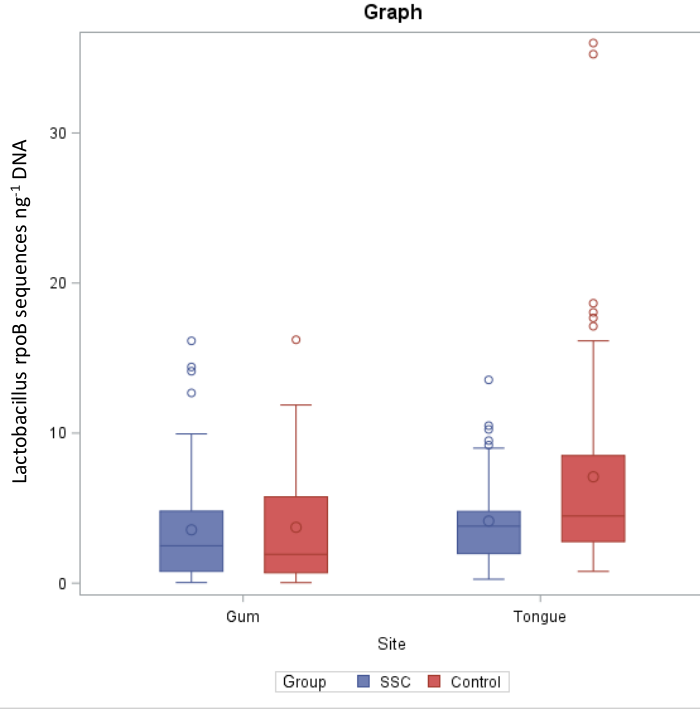
Figure 1. Lactobacillus spp.rpoB sequences (expressed as ng −1 of target DNA) quantified by qPCR in gums and tongues of SSc patients and healthy subjects (control).